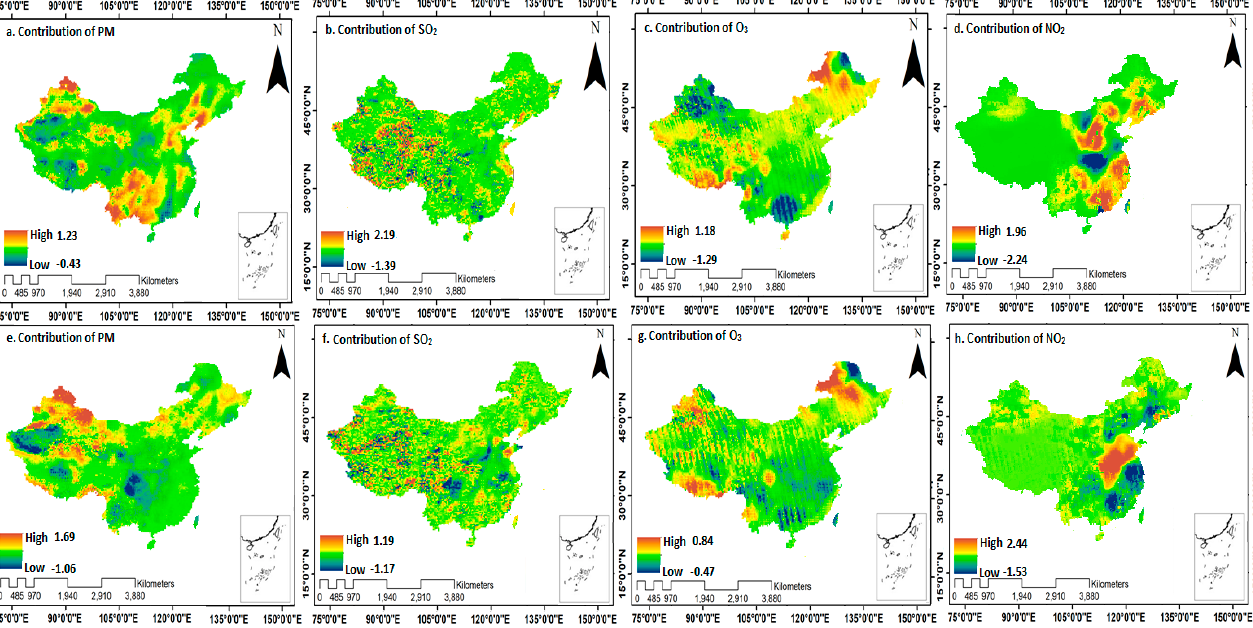
Figure 12. Contribution of air pollutants to temperature minimum (°C) pa tt ern changes. Note: Pre-scenario ( a , b , c , d ) and Post-scenario ( e , f , g , h ).